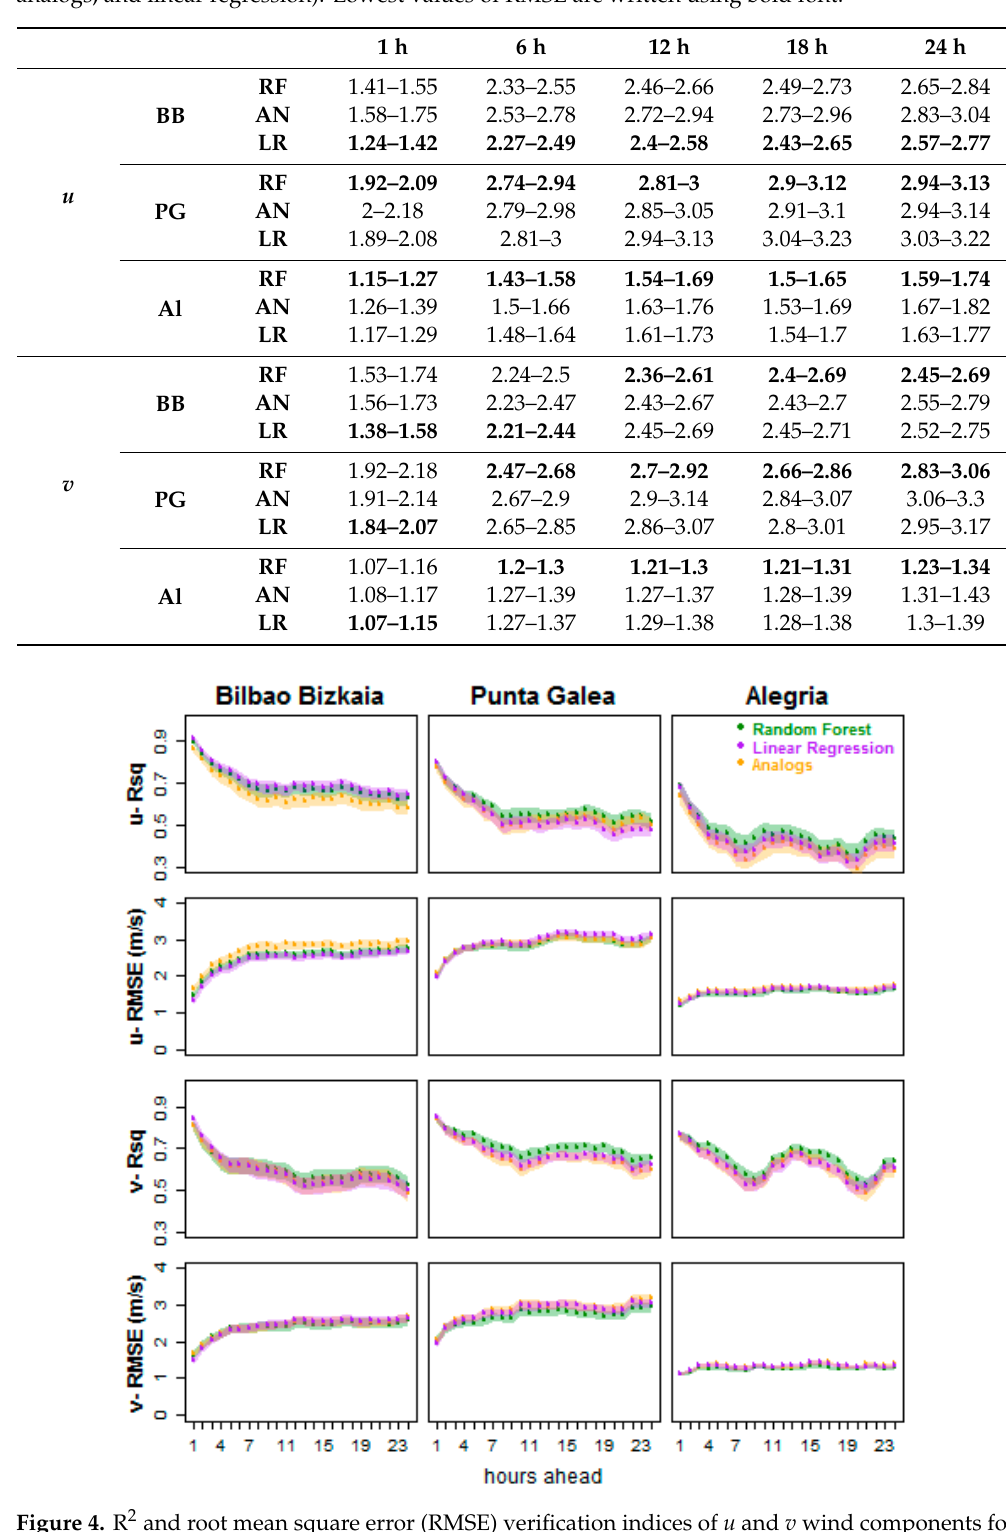
Figure 4. R 2 and root mean square error (RMSE) verification indices of u and v wind components for the coming 24 h, for three locations, and three statistical methods.